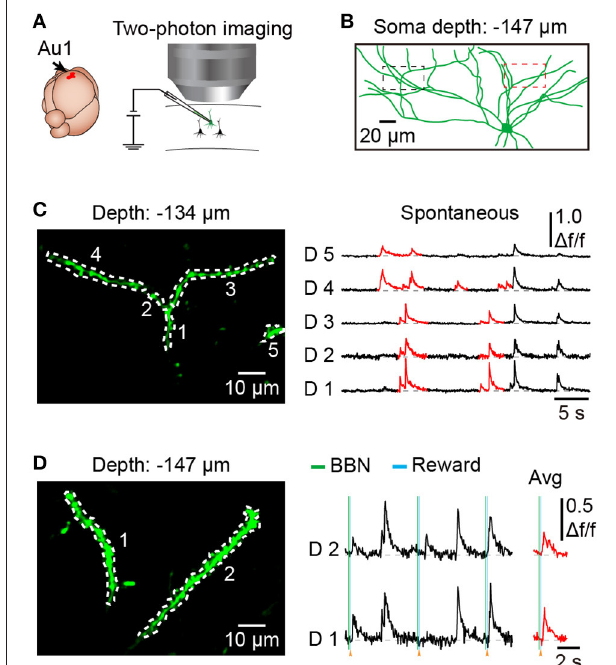
FIGURE 5 | Dendritic Ca 2 + imaging using electroporation in the Au1 of behaving mice. (A) Schematic of electroporation in the Au1. (B) Reconstruction of an electroporated neuron in the Au1, labeled with OGB-1. (C) Spontaneous Ca 2 + transients from 5 dendritic shafts (outlined in left part of B ). Local Ca 2 + transients are marked in red. (D) Dendritic Ca 2 + imaging from a region of the neuron during behavior (outlined in right part of B ). Average Ca 2 + transients related to the BBN are marked in